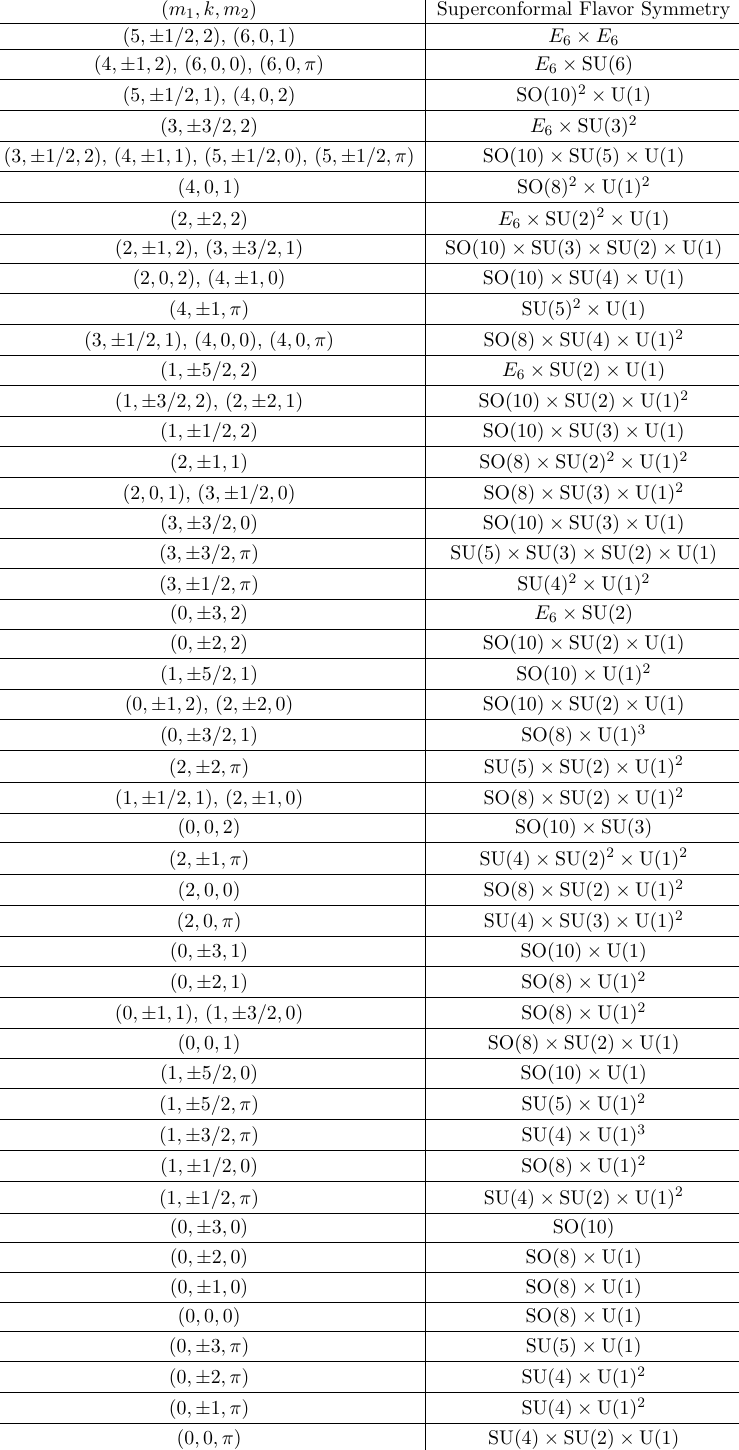
Table 4. Dualities among and superconformal (cid:13)avor symmetries for quivers of the form m 1 F (cid:0) We abuse notation and capture the (cid:18) -angle of the rightmost Sp(1) when it has no fundamental hypermultiplets by allowing m 2 = 0 ; (cid:25)